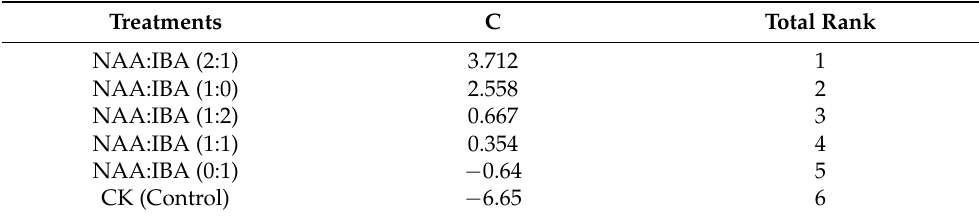
Table 6. Principal component scores and comprehensive scores of each process.